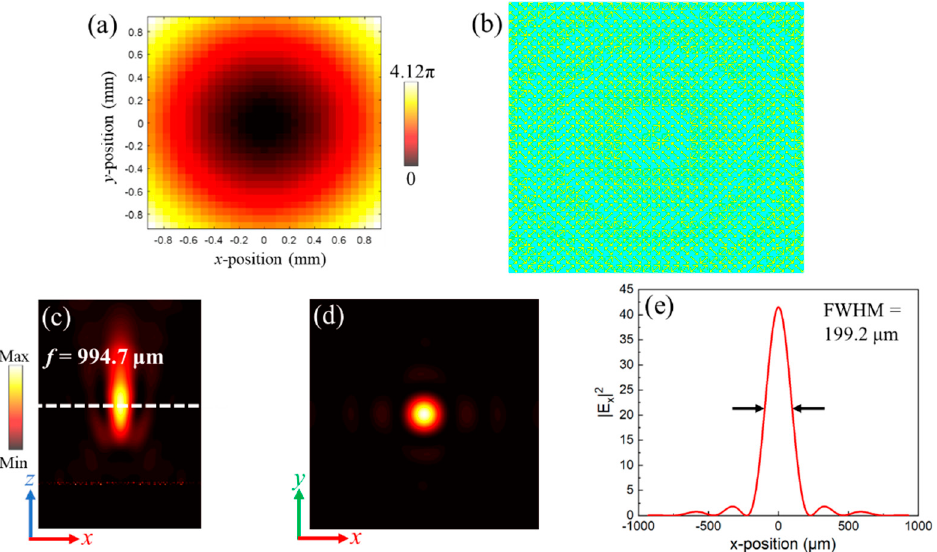
Figure 8. ( a ) The required phase compensations by step of 60 µ m in x - y plane. ( b ) The middle layer of designed 2D metalens (only the middle layer is depicted for clarity). The electrical field of cross-polarized waves | E x | 2 in ( c ) x - z plane and ( d ) x - y plane. ( e ) The profile of | E x | 2 in the focal plane.